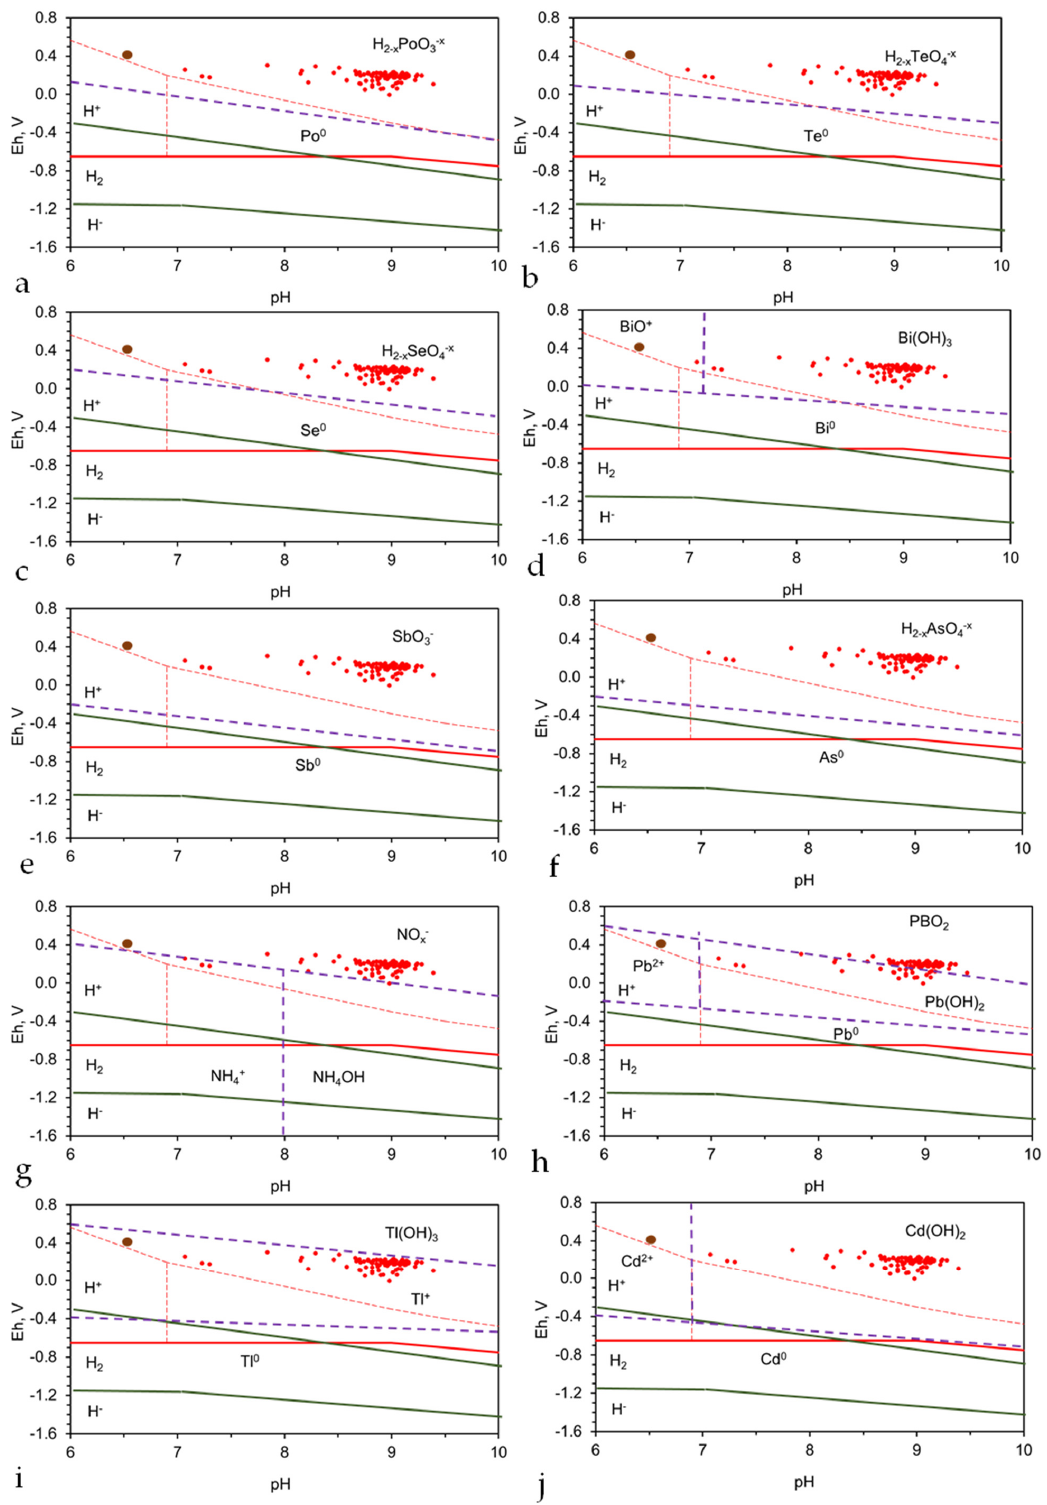
Figure A11. Eh and pH of product water (red dots) relative to redox fence locations. ( a ), Polonium; ( b ), Tellurium; ( c ), Selenium; ( d ), Bismuth; ( e ), Antimony; ( f ), Arsenic; ( g ), Nitrate/Nitrite; ( h ), Lead; ( i ), Thallium; ( j ) Cadmium. Dashed Purple Line = contaminant redox fence boundary; Eh:pH product water data: Figure A10; Brown data point = feed